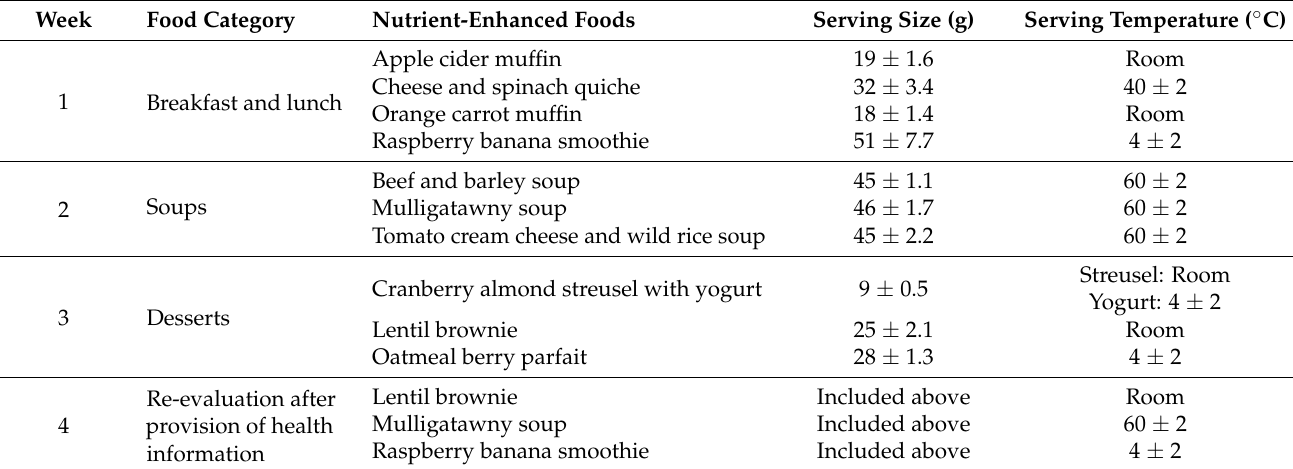
Table 2. Serving size and temperature of ten nutrient-enhanced foods used in sensory